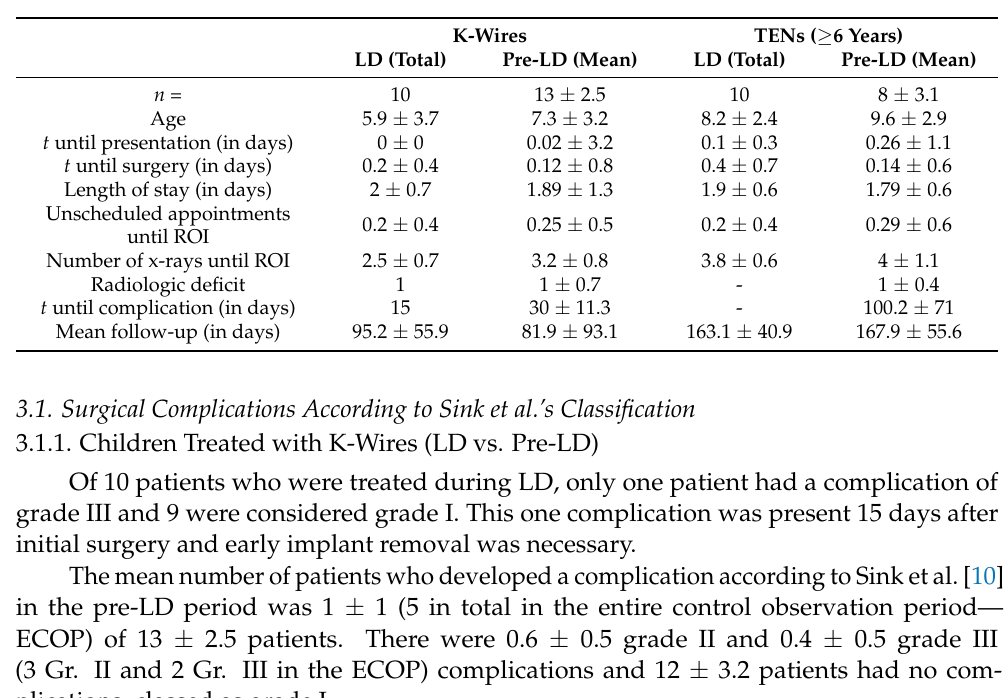
Table 2. Supplementary data describing the LD and pre-LD